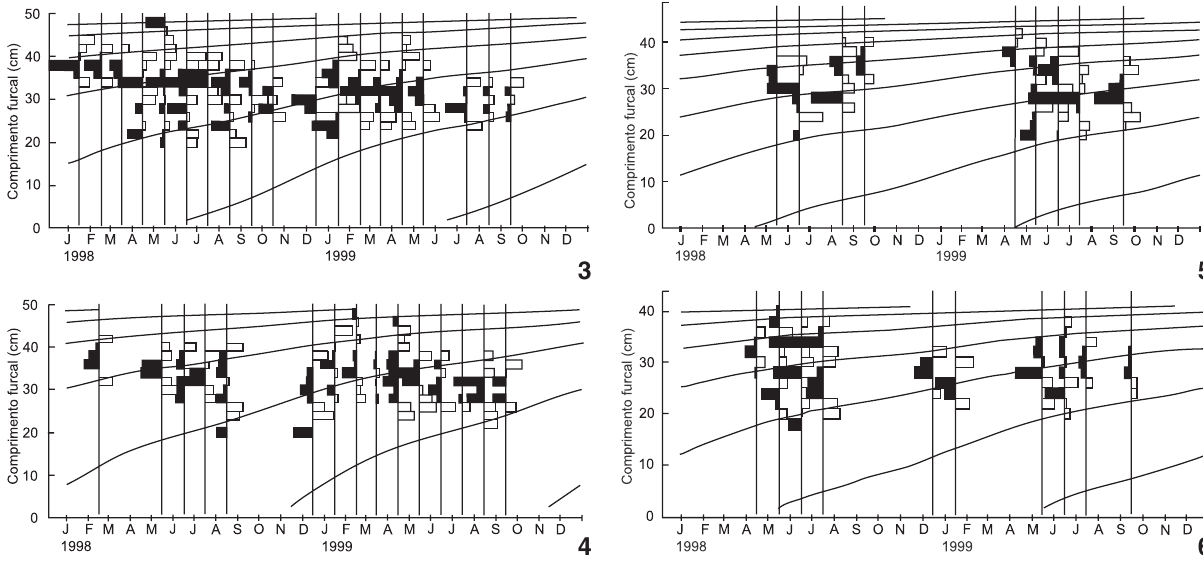
Figura 3-6. Distribuição ajustada de freqüências de comprimento do sub-sistema Purus (3), Madeira (4), Baixo Solimões (5) e Médio Solimões (6) com dados de 1998 e 1999 e linha de ajuste da CCVB de cada sub-sistema. As barras negras representam picos